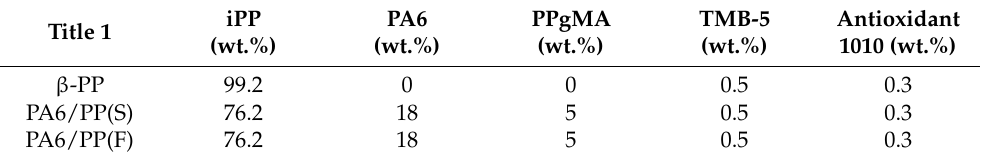
Table 1. Compositions of β -PP, PA6/PP(S), and PA6/PP(F)